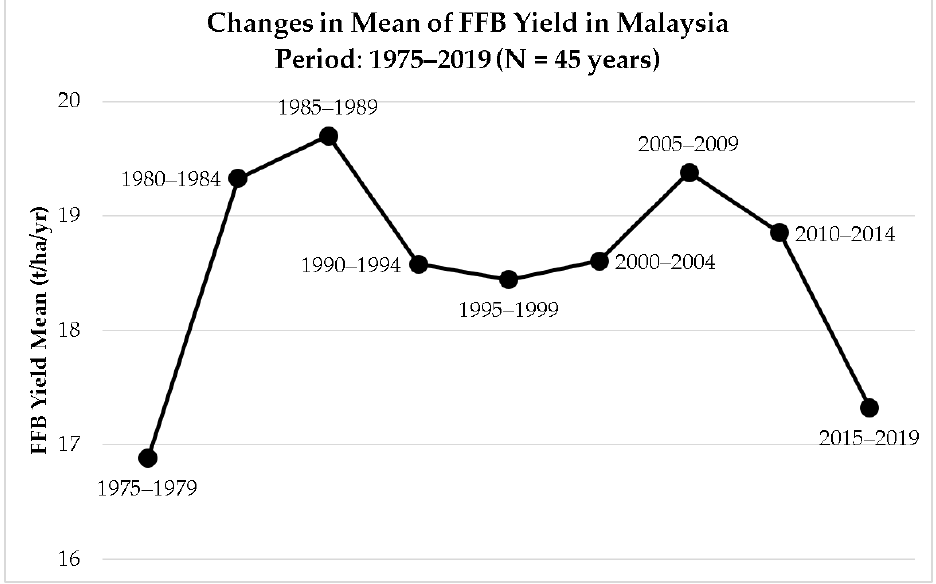
Figure 2. Changes in mean of FFB yield in Malaysia from 1975 to 2019 in moving 5-year intervals [7 – 9].